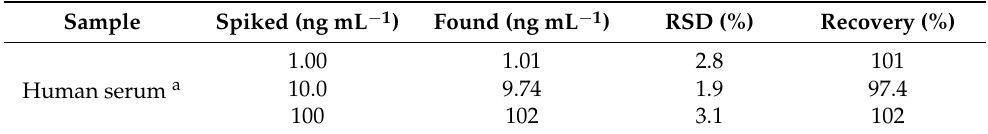
Table 1. Determination of PSA in human